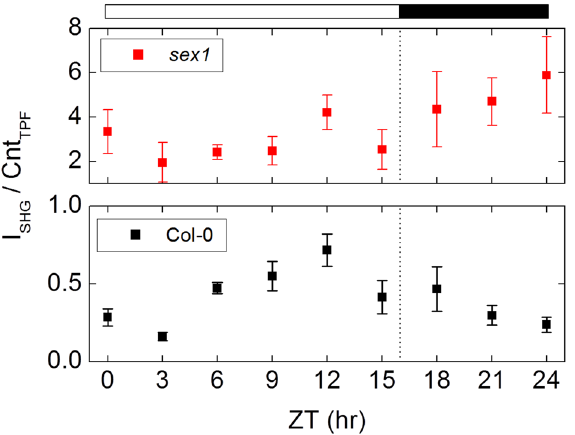
Figure 5. The ratio of SHG intensity to TPF pixel counts above threshold in the images were analyzed and plotted across a 16-h light/8-h dark diurnal cycle. The horizontal axis shows ZT hours, starting at 0 h after the light comes on (ZT0) and increments in 3 h intervals until ZT24. The bar on top indicates the hours when the growth chamber light was on and off, and the dashed line indicates ZT16 hour when the light in the growth chamber was turned off. Error bars correspond to one standard deviation based on 12 imaging areas of two leaves. (I SHG : summed intensity for pixels above SHG threshold of 2; Cnt TPF : total pixels above TPF threshold of